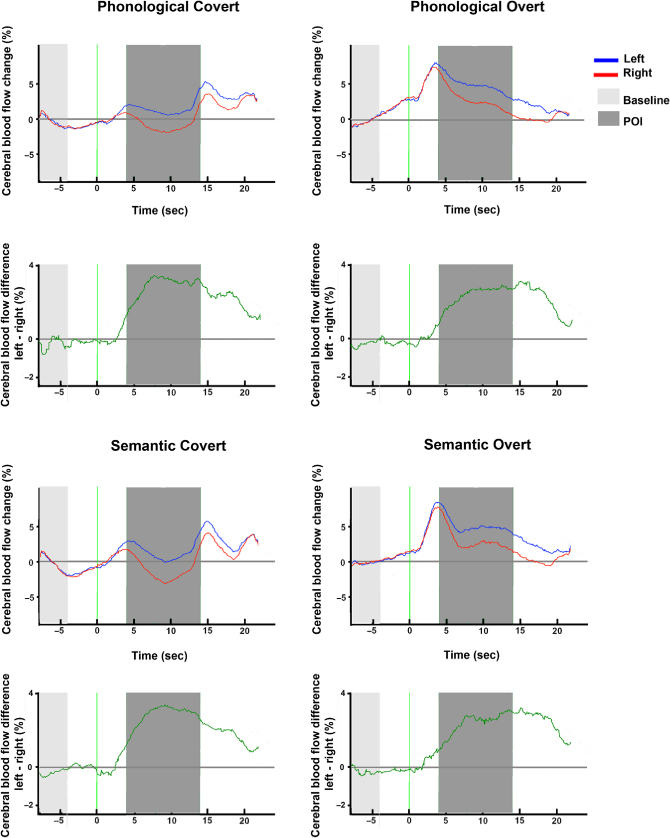
Average of participants' baseline-corrected cerebral blood flow velocity for the left (blue line) and right (red line) channels for each of the four conditions. The difference between left and right channels is shown below each condition. The baseline and periods of interest for the computation of LIs are shown in light and dark grey, respectively. [To view this figure in colour, please see the online version of this journal.]